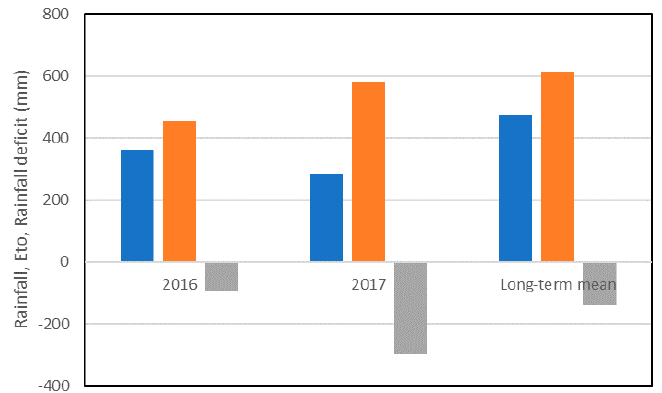
Figure 1. Rainfall (blue bars), reference evapotranspiration (ETo) (orange bars), and rainfall deficit (rainfall–ETo) (grey bars) between October and May for the years 2016 and 2017, plus the long-term mean (40 years; 1970–2010).